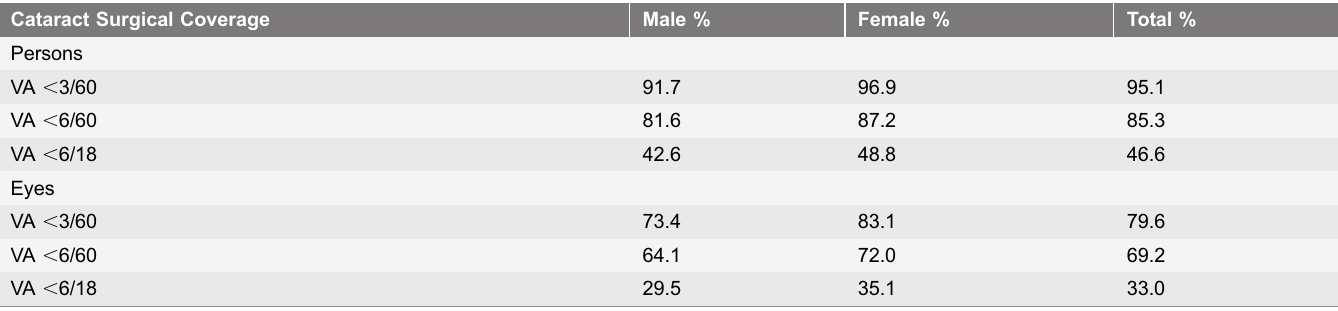
Table 7. Cataract surgical coverage in persons and eyes. Cataract Surgical